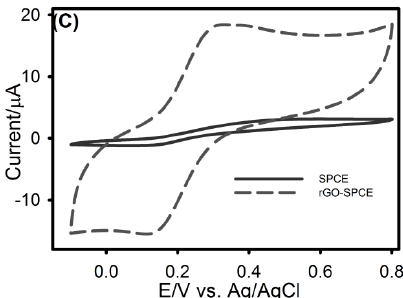
Figure 1. ( A ) UV-Vis spectra of GO and rGO suspensions in water. ( B ) Nyquist plots observed for impedance measurements at SPCE and rGO-SPCE in Britton–Robinson (BR) buffer (pH 7.0) containing 5.0 mM K 4 [Fe(CN) 6 ] and 0.1 M KCl. Insert: Randles equivalent circuit used for data fitting, R s , resistance of the electrolyte solution; R CT , electron-transfer resistance; Z w , Warburg impedance; C dl , double layer capacitance. ( C ) Cyclic voltammograms of 5.0 mM K 4 [Fe(CN) 6 ] in BR buffer (pH 7.0) containing 0.1 M KCl at SPCE and rGO-SPCE, 50.0 mV·s −1 scan rate.